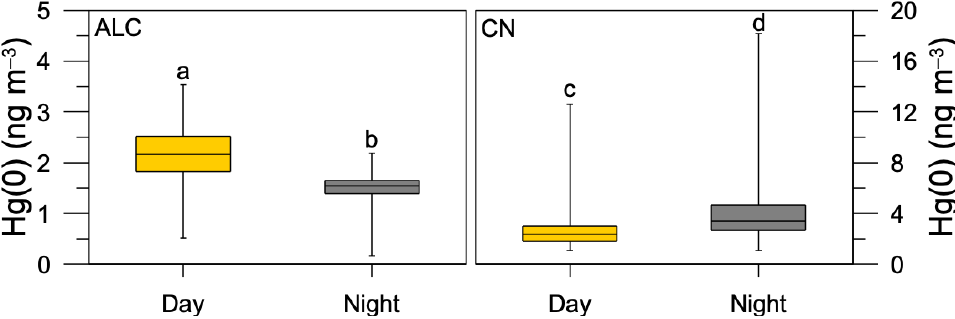
Figure 4. Air Hg(0) concentrations (ng m −3 ) in the vegetated saltmarsh areas from the background site ALC and the industrial site CN over day and night periods. Significant differences among groups observed (Mann–Whitney test; p < 0.05) are indicated with different letters.